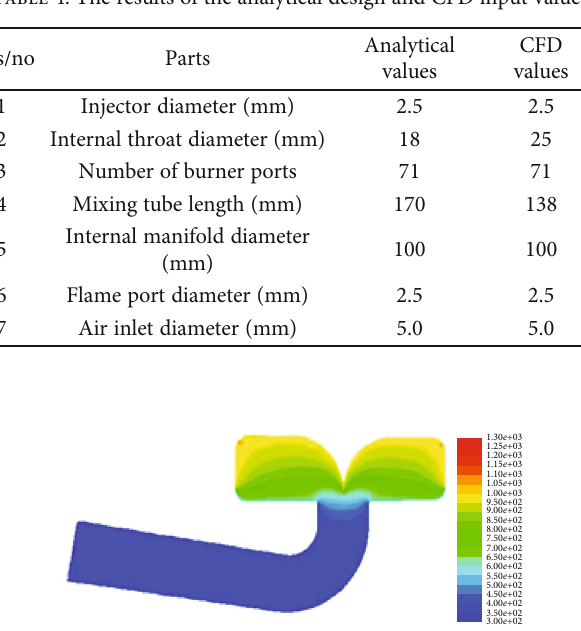
Table 4: The results of the analytical design and CFD input values.